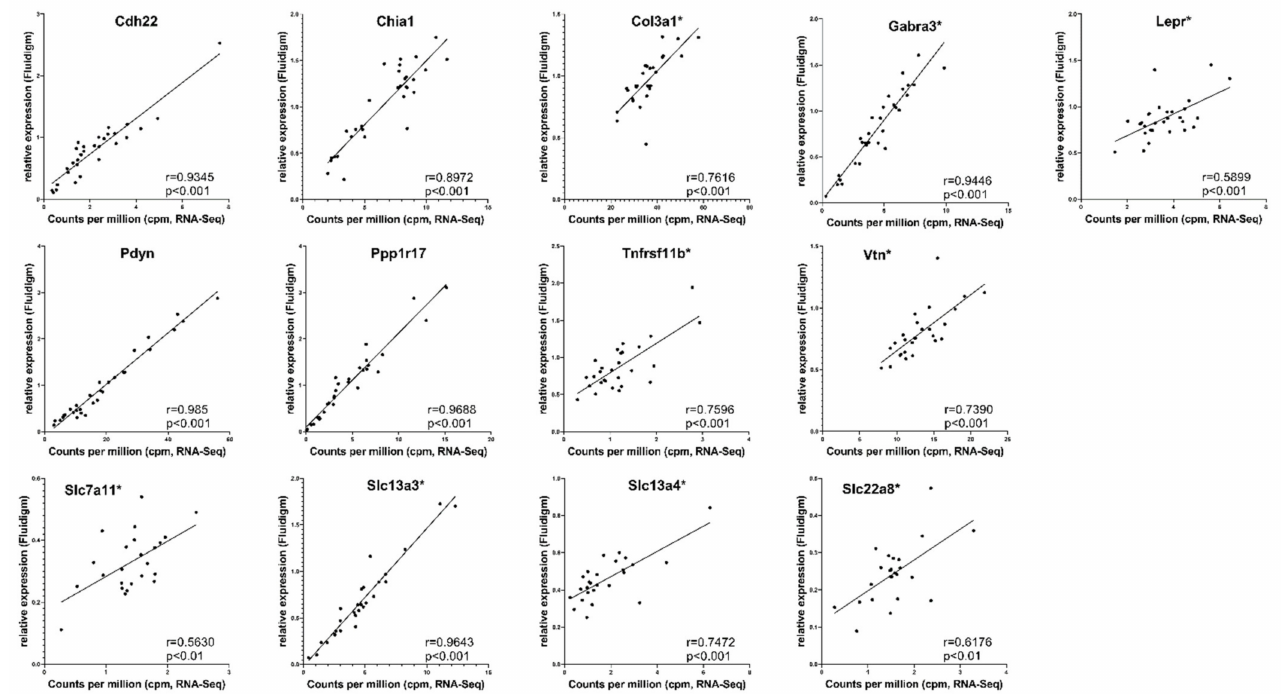
Figure 2. Validation of RNA-seq data by the Fluidigm technique for 13 differentially expressed genes (DEGs) from selected pathways in the pituitary gland. For each gene, the total reads (count per million, cpm) obtained by RNA-seq were plotted on the x -axis and RT-qPCR data (2 − ∆∆ Ct ) on the y -axis. Stars at the gene name indicate that outliers were removed during processing, as described in Materials and Methods. Corresponding correlation coefficients (r) and p -values are